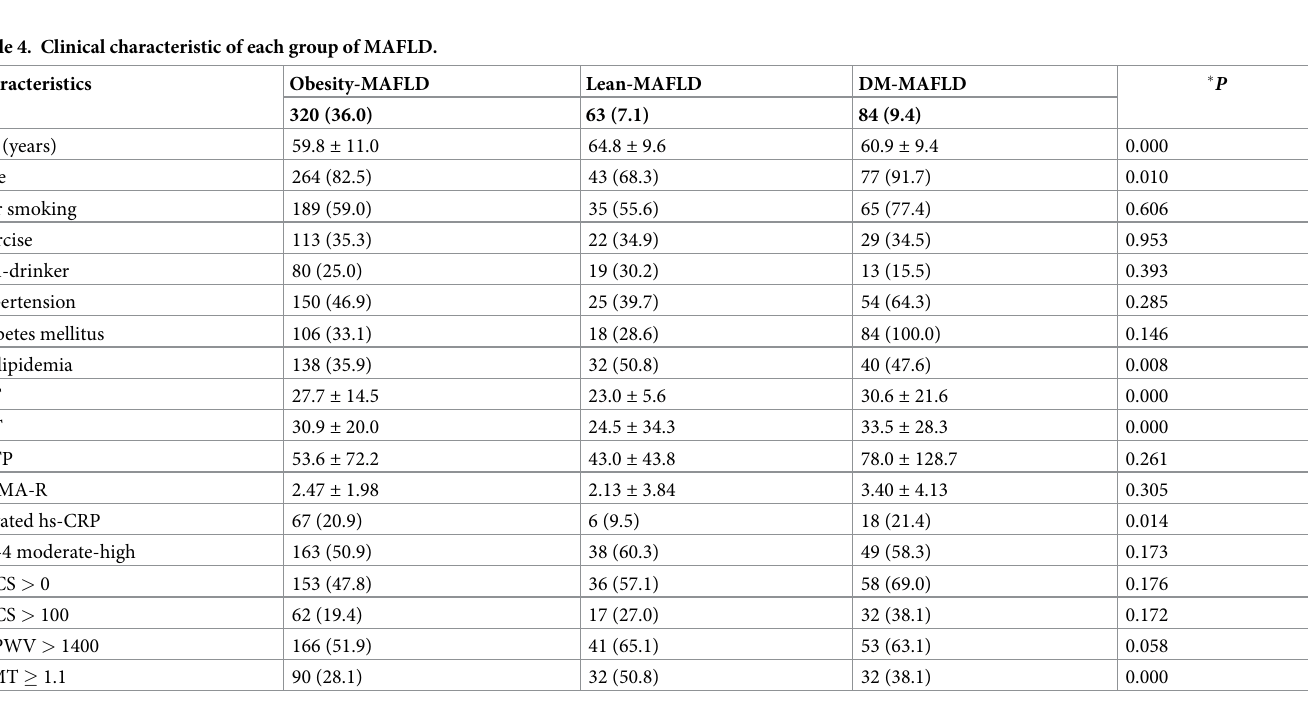
Table 4. Clinical characteristic of each group of